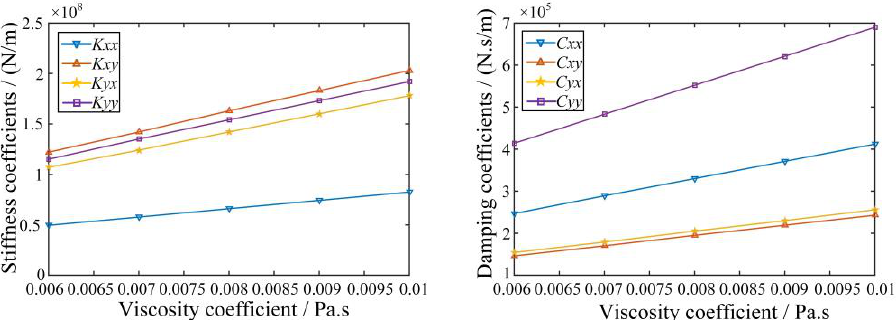
Figure 8. Variation tendencies of the dynamic coefficients for different ratio of length to diameter λ .